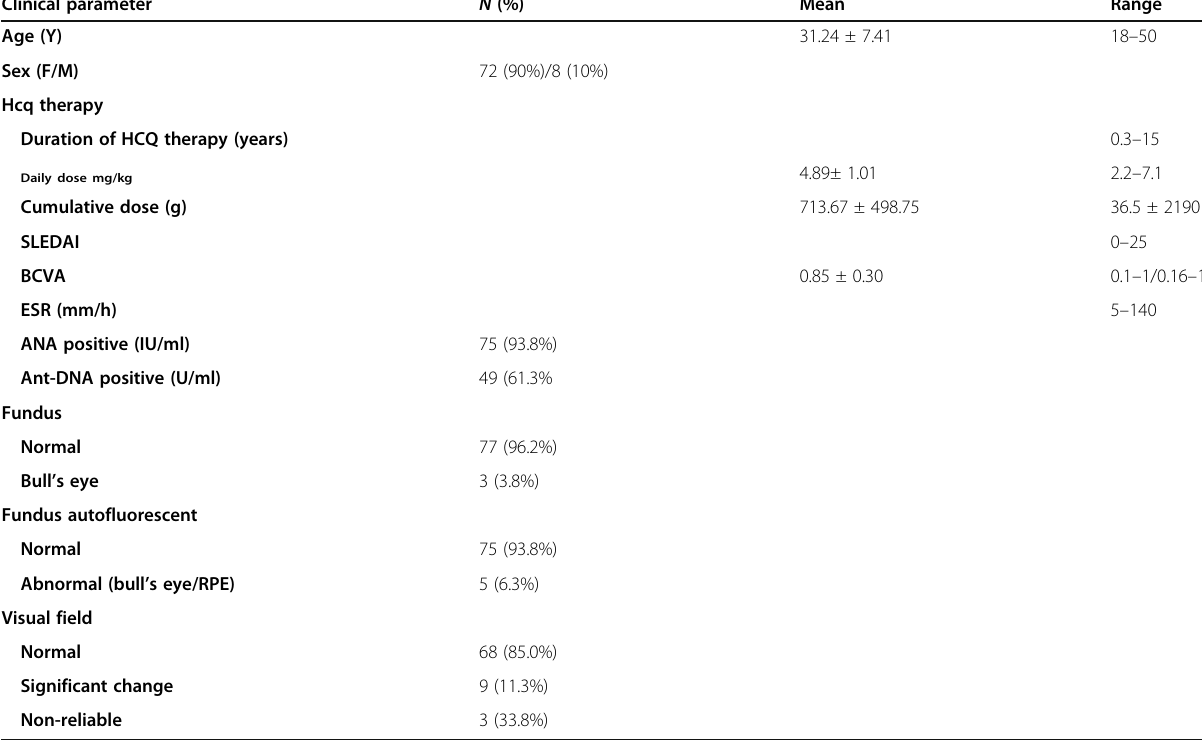
Table 1 Clinical data of SLE patients at the time of enrollment Clinical